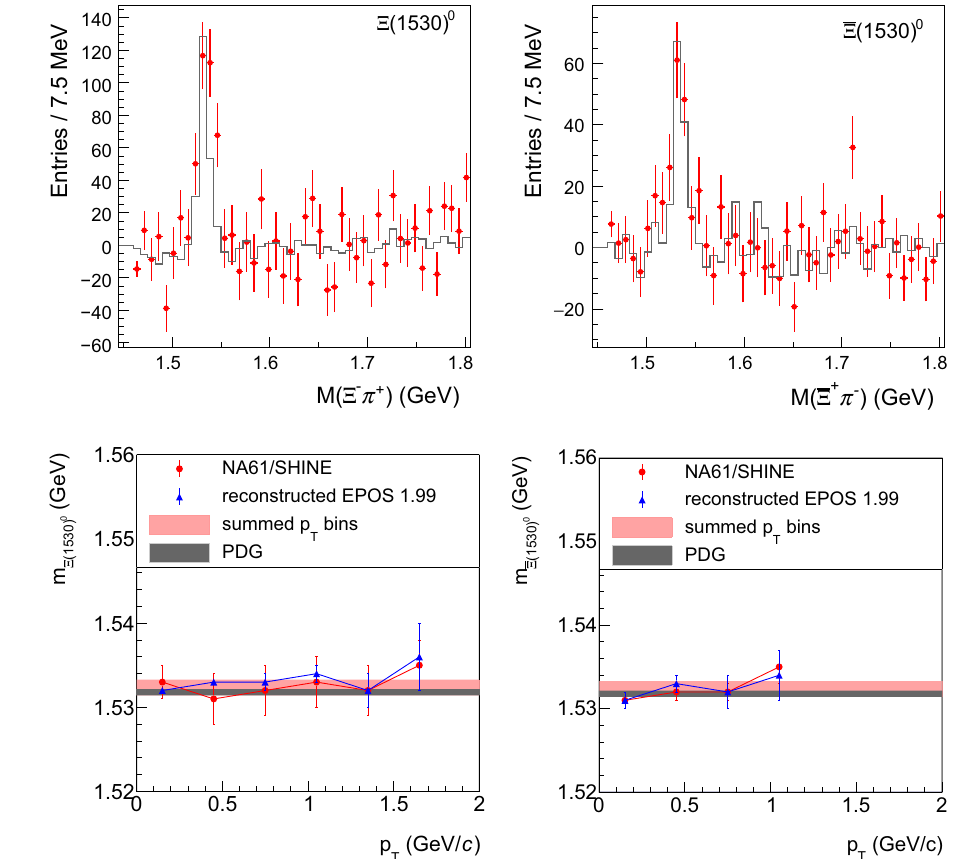
Fig. 5 Background-subtracted invariant mass distribution of (cid:2)( 1530 ) 0 ( left panel) and (cid:2)( 1530 ) 0 ( right panel) in the rapidity range − 0 . 25 < y < 0 . 25 and transverse momentum range 0 . 30 GeV / c < p T < 0 . 60 GeV / c from data (red points), and from Epos 1.99 with full detector simulation and standard track and reconstruction procedures (gray histogram)